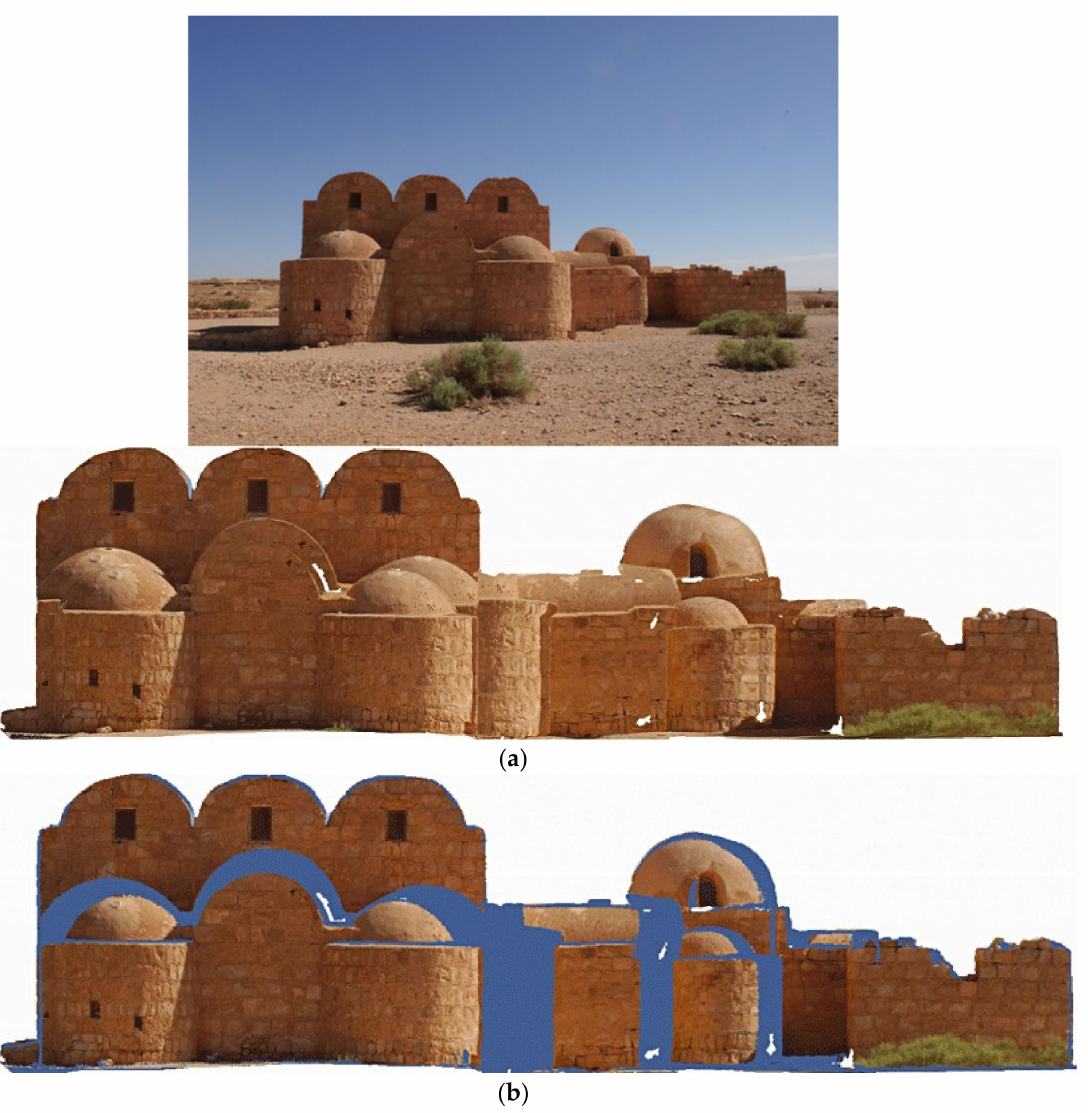
Figure 20. Qusayr ‘Amra façade: ( a ) Di ff erential rectification and double mapping problem; ( b ) true orthophoto with occluded areas in